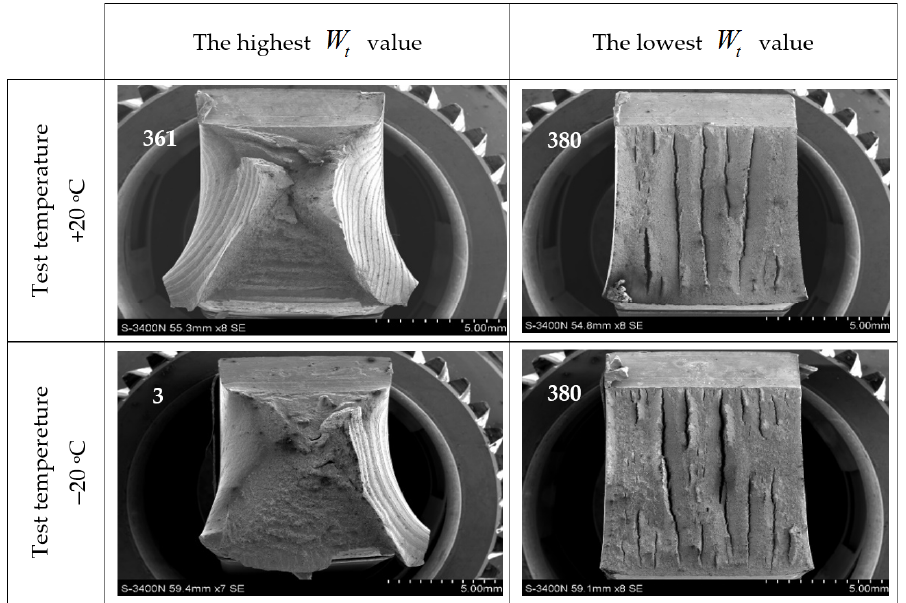
Figure 16. Characteristic impact-notch toughness test fractures obtained on samples made of X2CrNiMoN22-5-3 steel. X2CrNiMoN22-5-3